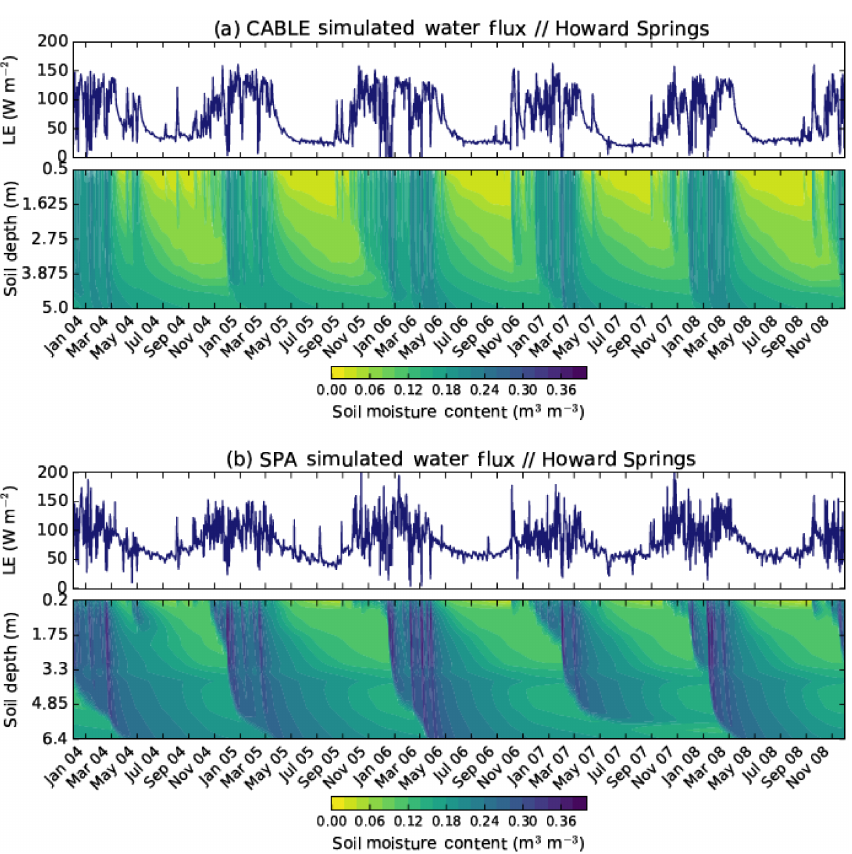
Figure 4. Simulated differences in total ecosystem latent energy (LE) and the resultant evolution of soil-moisture content through the soil profile over time for a mesic Australian savanna site. Simulations were conducted using two different terrestrial biosphere models (TBMs) that use different root-water extraction schemes. Panel (a) shows outputs of savanna water flux using the Community Atmosphere Biosphere Land Exchange (CABLE) model, where soil-water extraction is controlled by the density of the fine-root biomass. Panel (b) shows outputs of savanna water flux from the soil–plant–atmosphere (SPA) model, where soil water is dynamically extracted from where it is available. Model outputs are from Whitley et al.